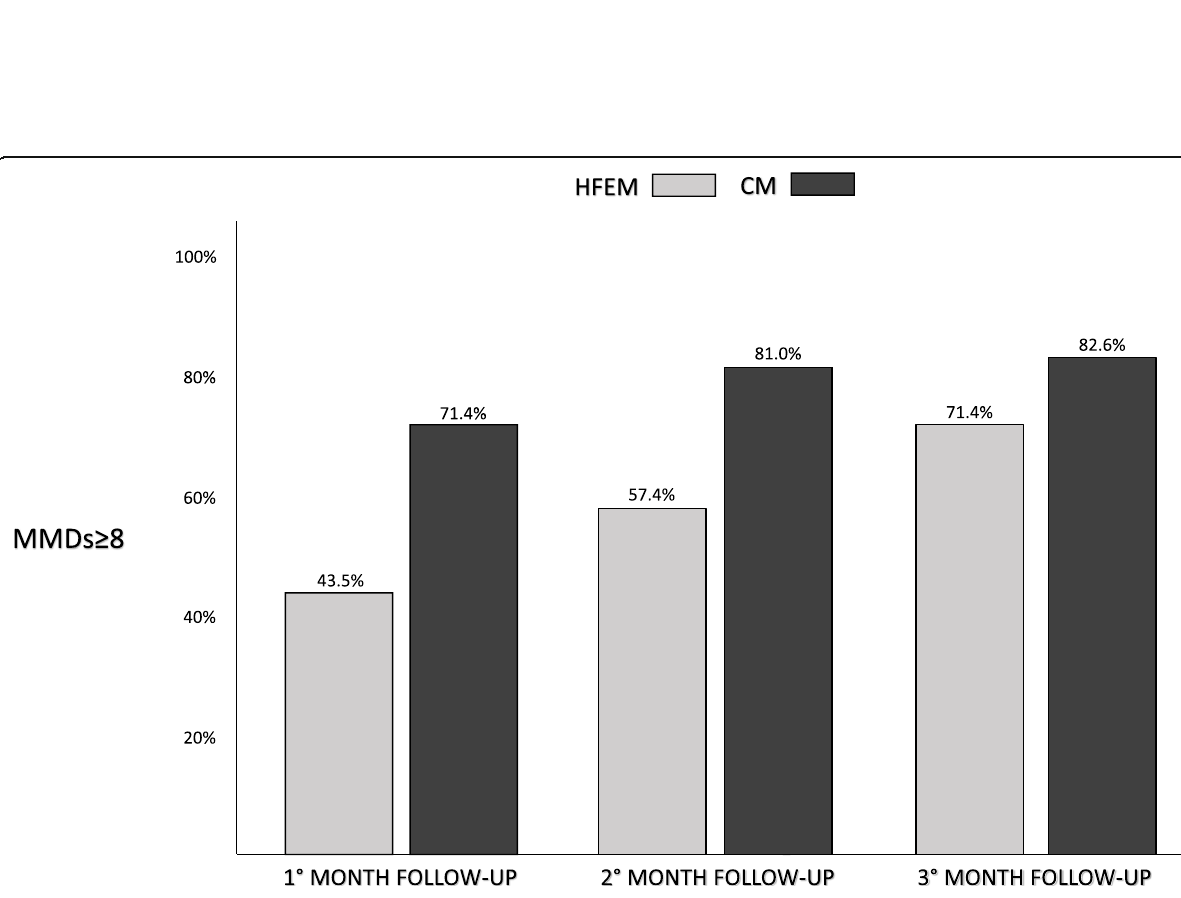
Fig. 2 The frequency of patients having at least 8 MMDs in the three months of mAbs anti-CGRP pathway discontinuation in CM and HFEM